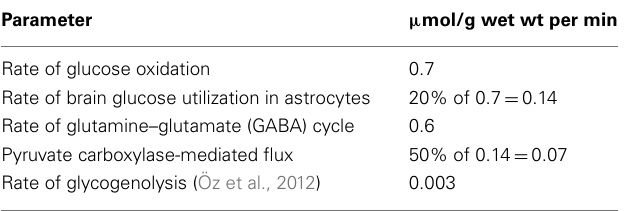
Table 1 |Approximate metabolic rates in the non-anesthetized brain cortex from a multitude of 13 C-NMR studies cited in text.